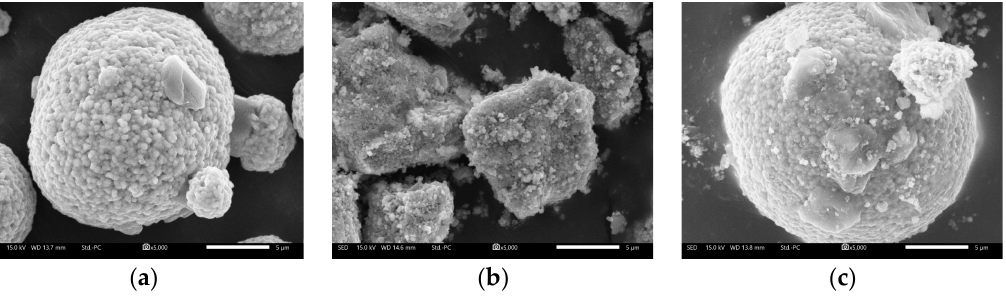
Figure 4. SEM micrographs of the precursors ( a ) K ‐ NMC ‐ 811, ( b ) SM ‐ LNMCO ‐ 811, and ( c ) SX ‐